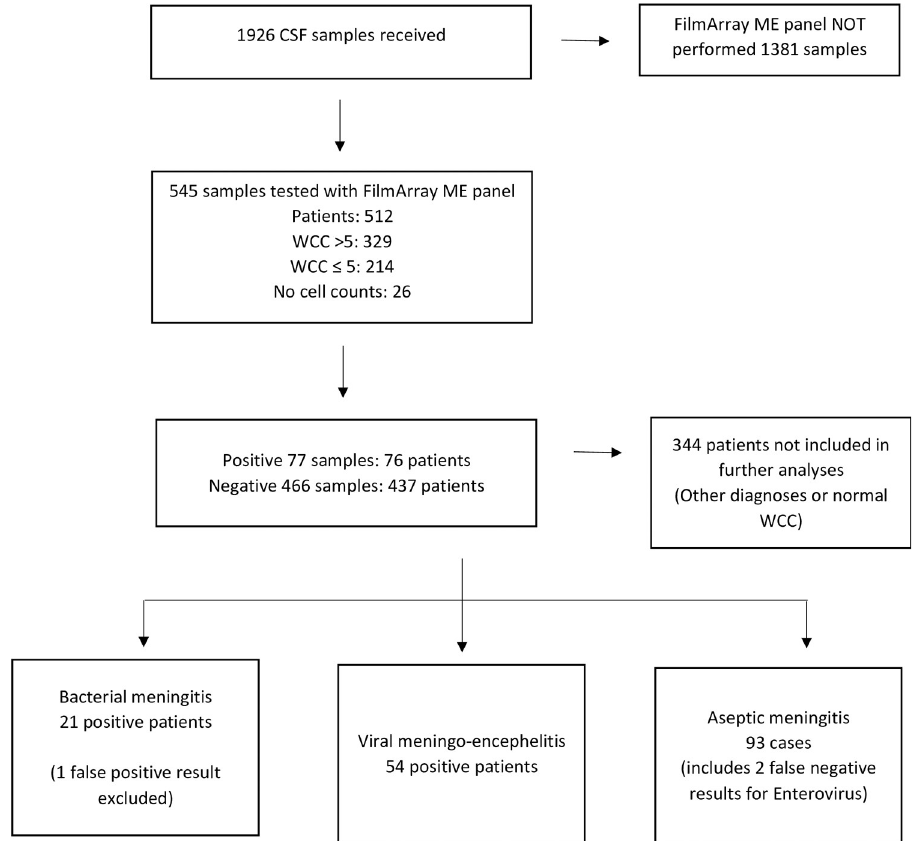
Fig 1. CSF samples and patients during study